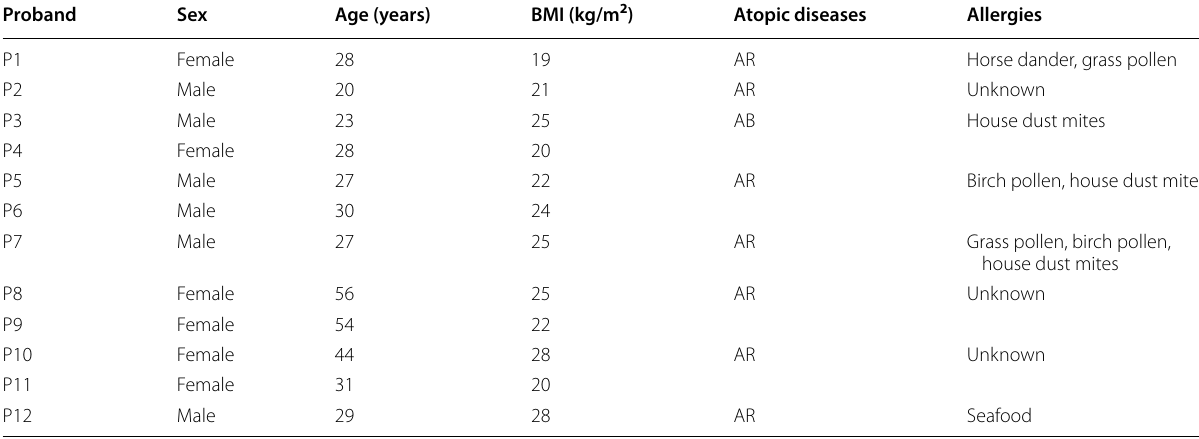
Sex, age, body mass index and atopy AB bronchial asthma, AR allergic rhinitis, BMI body mass index